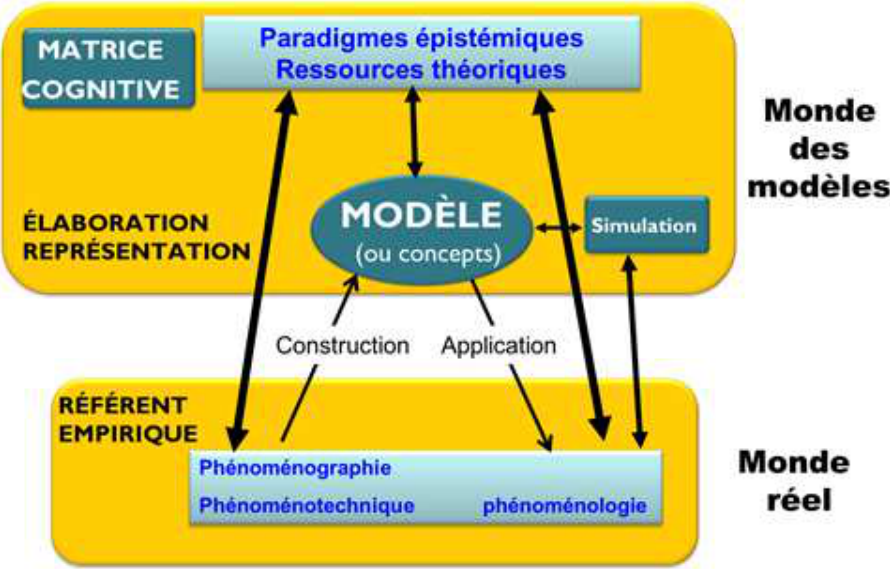
Fig. 1. L’activité de la modélisation dans la classe selon Martinand